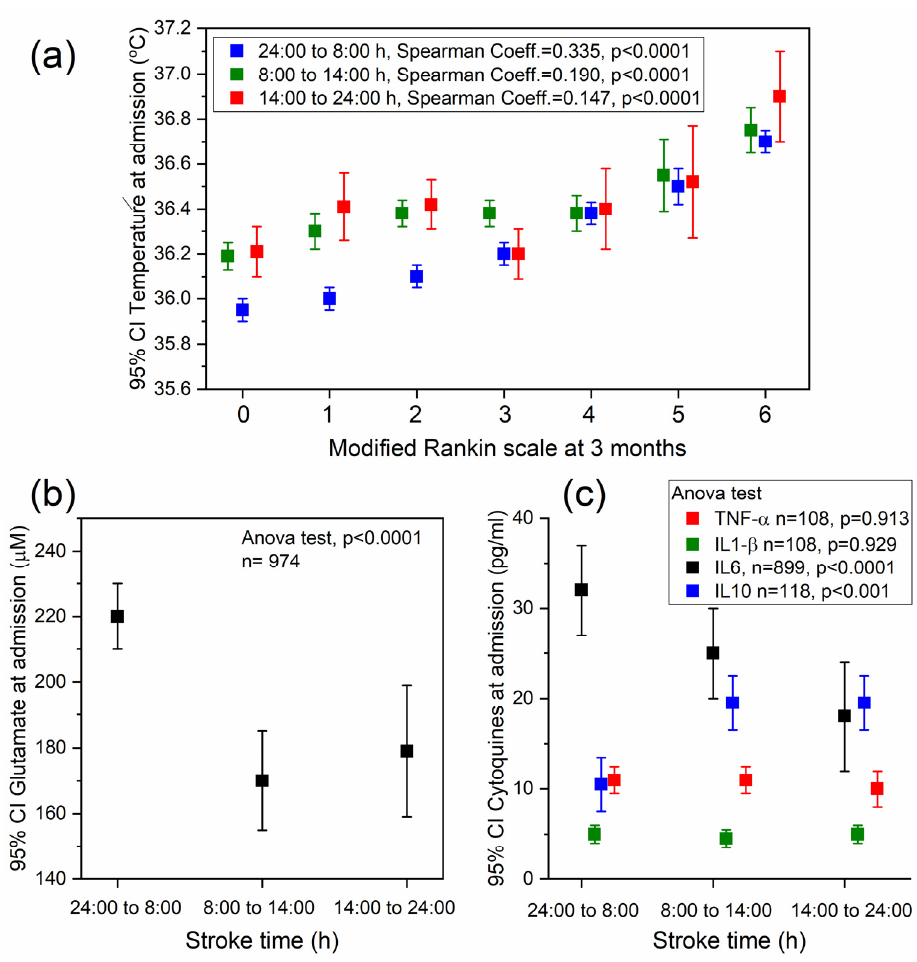
Figure 5. ( a ) Relationship between temperature at admission and modified Rankin scale at 3 months. Relationship between stroke time and ( b ) plasma glutamate and ( c ) cytokines at Table 1. Logistic regression model for temperature and NIHSS at admission, age, and reperfusion treatment. Dependent variable: poor outcome at 3 months.